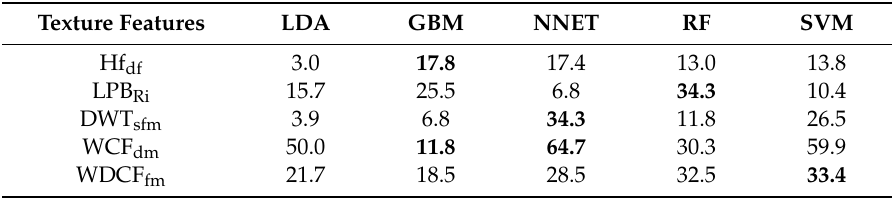
Table 2. Highest kappa (in %) achieved by each family of texture descriptors for all classifiers tested (in bold letters the best result achieved by each texture